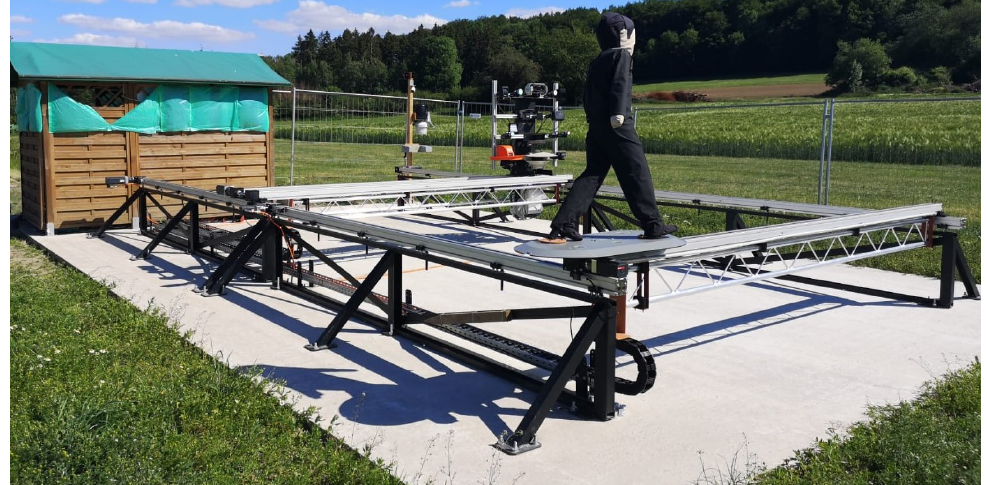
Figure 13. The figure shows the real test stand on an agricultural farm. In the foreground is the test target. Behind it the sensor holder is shown in the figure. Left of the sensor holder the extended weather station with the visibility measuring device and the camera is shown. In the upper left corner of the figure, a hut with the test stand control is